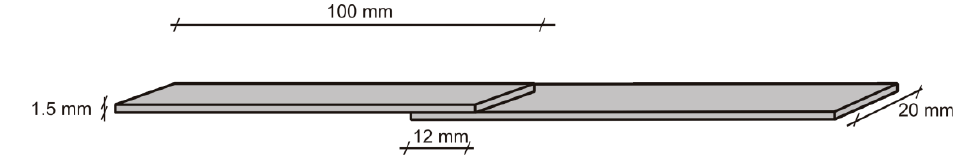
Figure 1. Lap specimen used in bondline strength measurements.